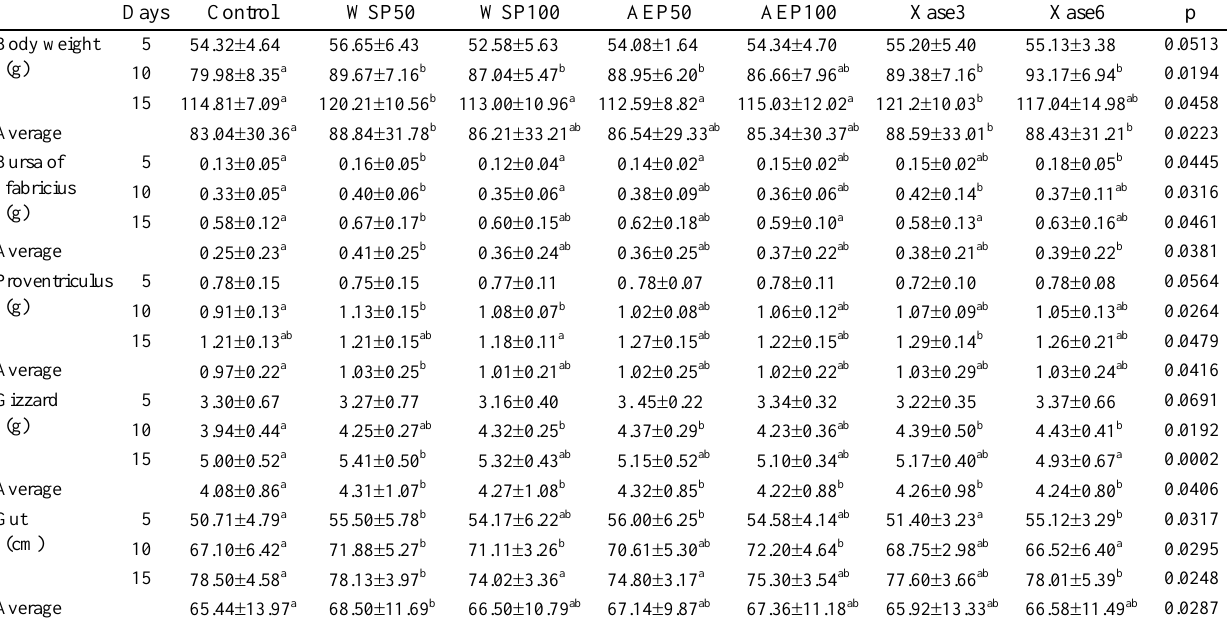
Table 2. Effects of pentosan and xylanase on growth and organ development of broiler chicks Days